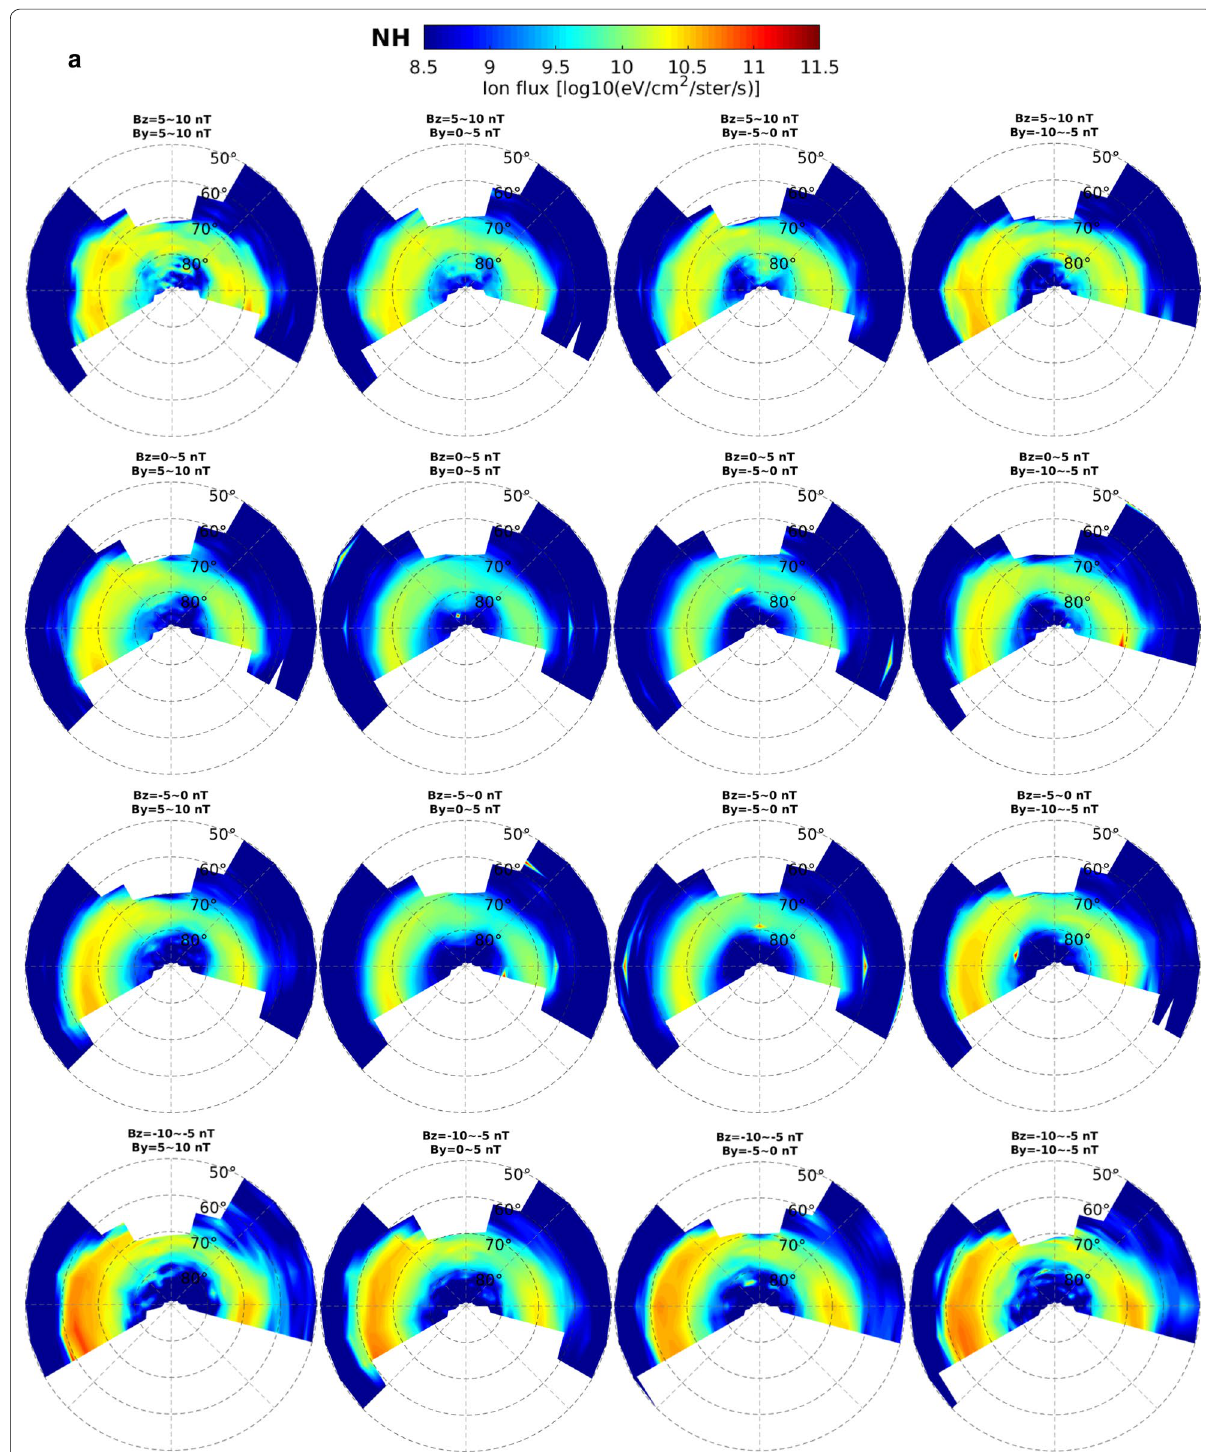
Fig. 6 a The MLAT versus MLT distribution of ion energy flux derived from the DMSP satellites for the northern hemisphere. b As the same as Fig. 6a, but for the ion energy flux distribution in the southern